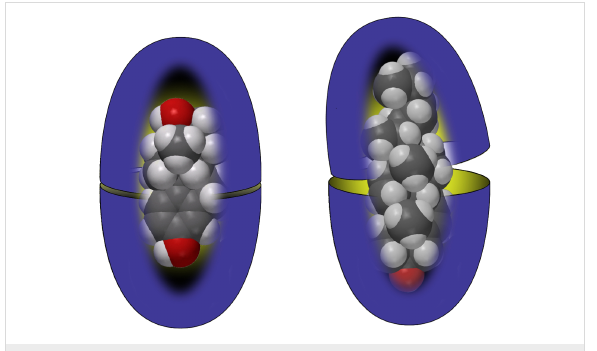
Figure 6: Cartoons of the 2:1 host–guest complexes of estradiol (left) and cholesterol